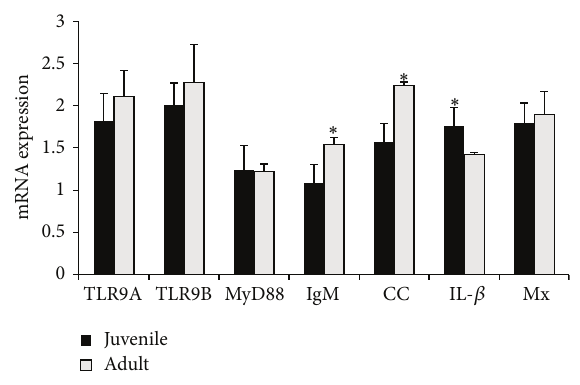
Figure 2: Quantitative analyses of toll-like receptor 9 and immune- relatedgeneexpressioninintestineofjuvenileandadult.Therelative expression variance is showed as ratio (the amount of gene mRNA expression normalized to the corresponding beta actin values). Data are shown as mean ± SD ( 𝑛 = 2 ). The significant difference is indicted with asterisk ( ∗ ) in the